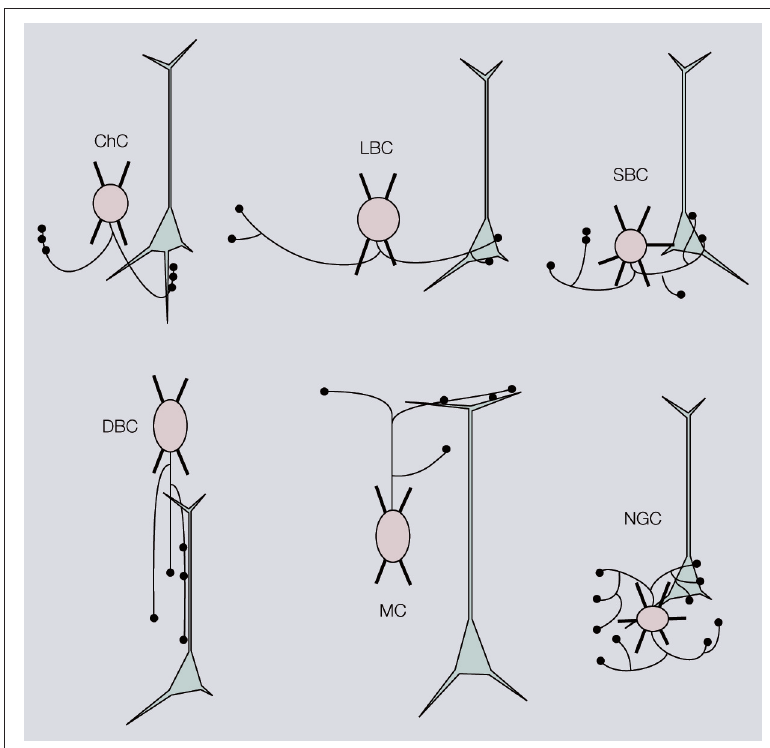
Figure 1 | Six distinct morphological types of interneurons. Diagrams showing different morphological types of interneurons (red), which were identified by cluster analyses of the subcellular distribution of axonal projections onto somata and dendrites of postsynaptic pyramidal neurons (gray). Chandelier cells (ChC), small basket cells (SBC), large basket cells (LBC), neurogliaform cells (NGFC), double bouquet cells (DBC) and Martinotti cells (MC). For examples of non-diagrammatic reconstructions of interneurons from rat somatosensory cortex and monkey prefrontal cortex see Krimer et al. (2005), Huang et al. (2007) and Ascoli et al.